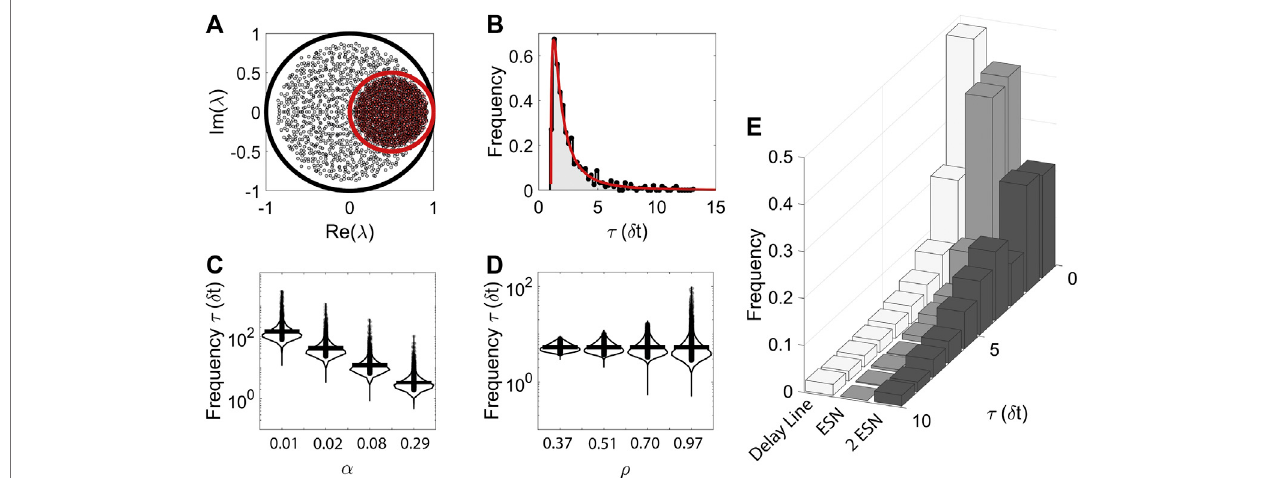
FIGURE 1 | The analysis of the timescales of the system in the linear regime can guide the search for the optimal values of the hyper-parameters α and ρ . (A) : Translation and scaling of the eigenvalues of the system due to the presence of the leakage factor. (B) : Example of distribution of timescales, computed analytically (red line) and computationally (black points) estimated from the eigenvalues of W . (C) : Pirate plot of the distributions of timescales as α increases. Both axes are logarithmic. Higher α values correspond to longer timescales and to a more compressed range of timescales (logarithmic y -axis). (D) : Pirate plot of the distributions of timescales: as ρ increases, the range of timescales expands. Again, both axes are logarithmic. (E) : Example distributions of timescales for reservoirs with different connectivity structure. From left to right, a delay line, single ESN, 2 ESNs (connected and unconnected, see text for the reason why the timescales for these two structures are the same in the linear regime). The higher complexity of the models reported is re fl ected in a richer distribution of